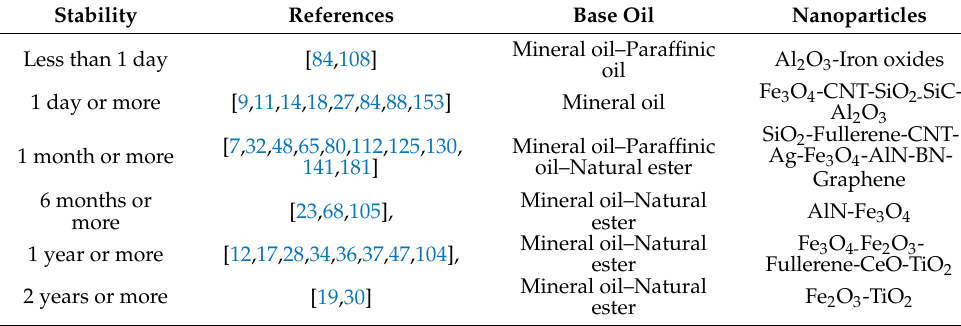
Table 12. Stability lasting of nanofluids in the analyzed